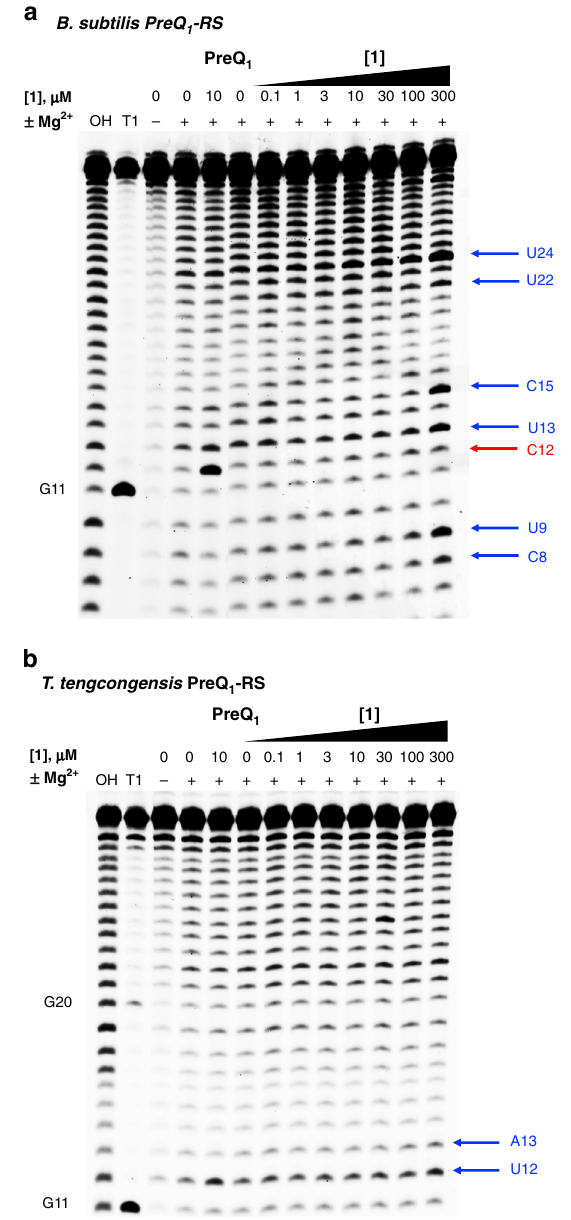
Fig. 4 Ligand-induced conformational changes. In-line probing of a 5 ′ - AlexaFluor 647-labeled Bs PreQ 1 -RS RNA and b 5 ′ -AlexaFluor 647-labeled Tt PreQ 1 -RS RNA after treatment with 1 at increasing concentrations or a DMSO control in the absence ( – ) or presence ( + ) of 1 m M MgCl 2 . Treatment with PreQ 1 at a concentration of 10 μ M is used as a positive control. OH and T1 are a partial alkaline hydrolysis ladder and ribonuclease T1 digestion, respectively. Arrows designate nucleotide positions where the cleavage ef fi ciency was signi fi cantly altered by compound treatment (blue) or preQ 1 treatment